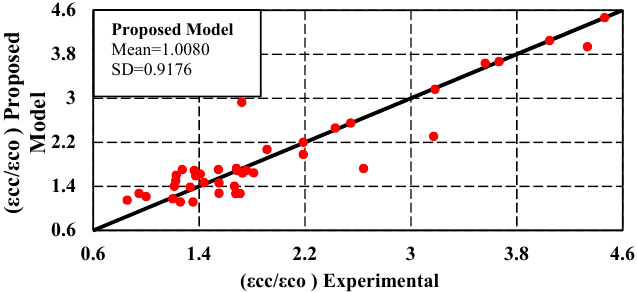
𝛆 𝐜𝐜 Figure 11. Comparison of ε cc Figure 11. Comparison of values obtained from the proposed model (Equation (16e)) and ex- ε c o values obtained from the proposed model (Equation (16e)) and 𝛆 𝐜𝐨 experimental perimental data.